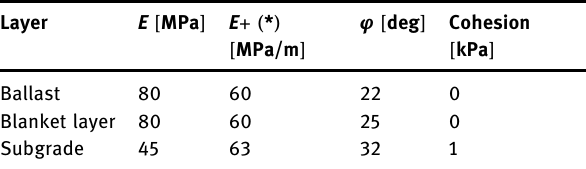
Table 4: Parameters of the track structure for calculations Parameters Values